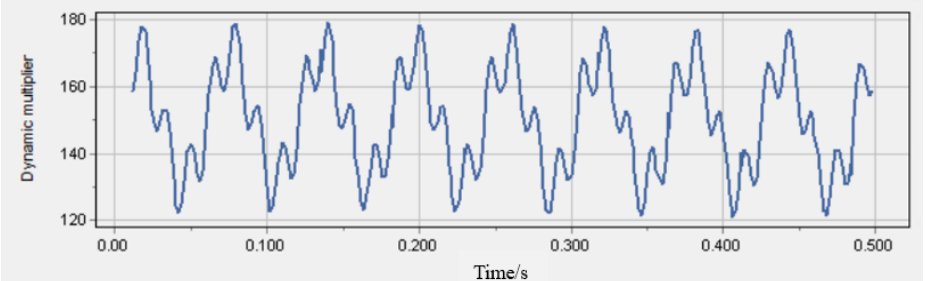
Figure 7. Time range curve of train dynamic load.